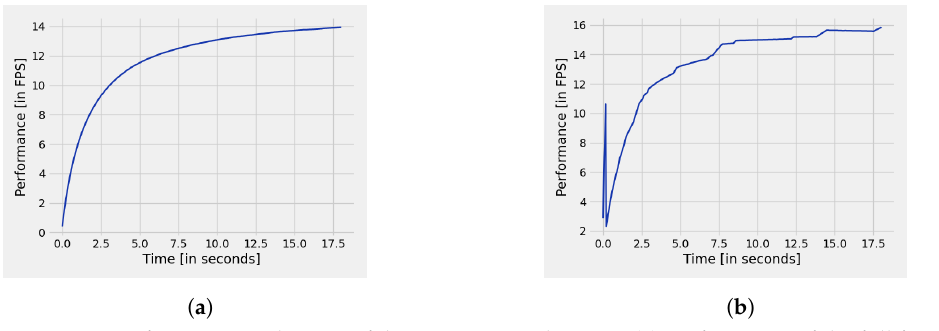
Figure 11. Performance evaluation of the YOLOv4 on the GPU. ( a ) Performance of the full frame on the GPU; ( b ) performance of the part of the frame on the